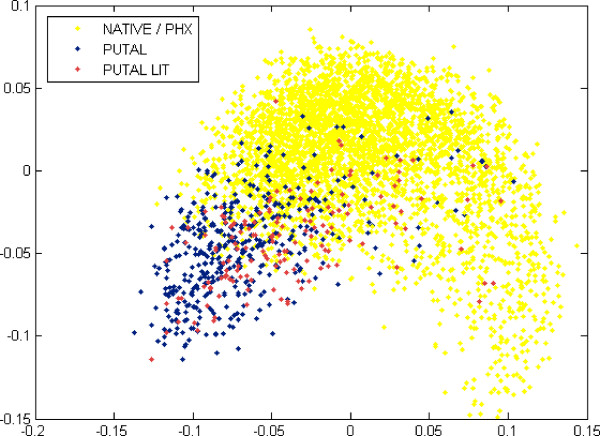
Kernel-based scatter plot visualization of SIGI-HMM predictions for E. coli K-12. Blue points (PUTAL) represent pA genes as predicted by SIGI-HMM, red points (PUTAL LIT) indicate predicted pA genes with additional evidence from the current literature as described in the text. Yellow points (NATIVE / PHX) refer to genes which are predicted to be native or highly expressed.